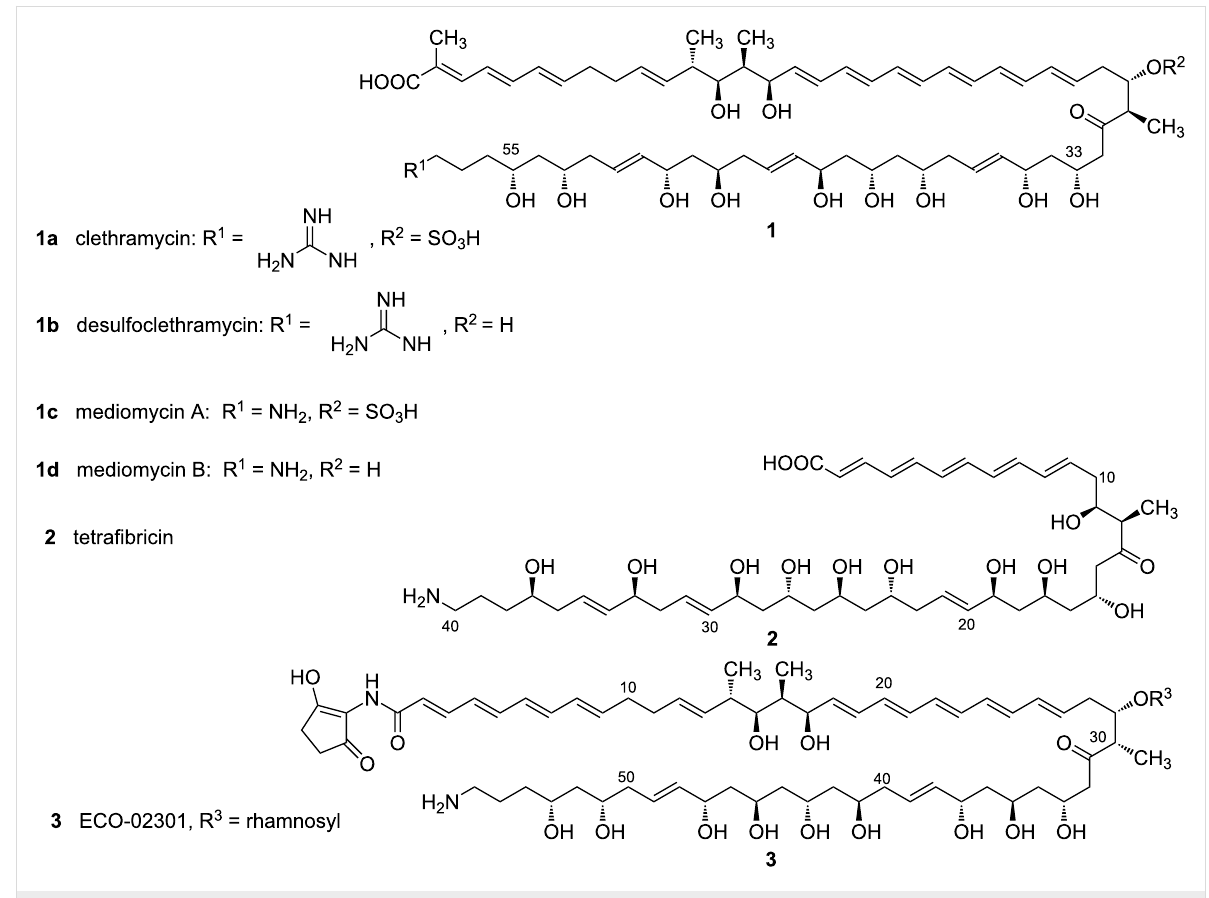
Scheme 1: The structures of clethramycin, mediomycins and related linear